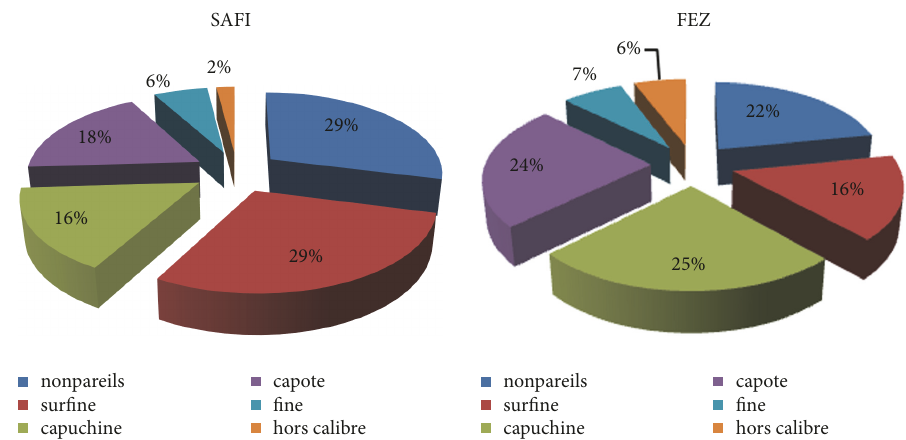
Figure 4: Calibers of Moroccan Capparis spinosa seeds collected from FEZ and SAFI.